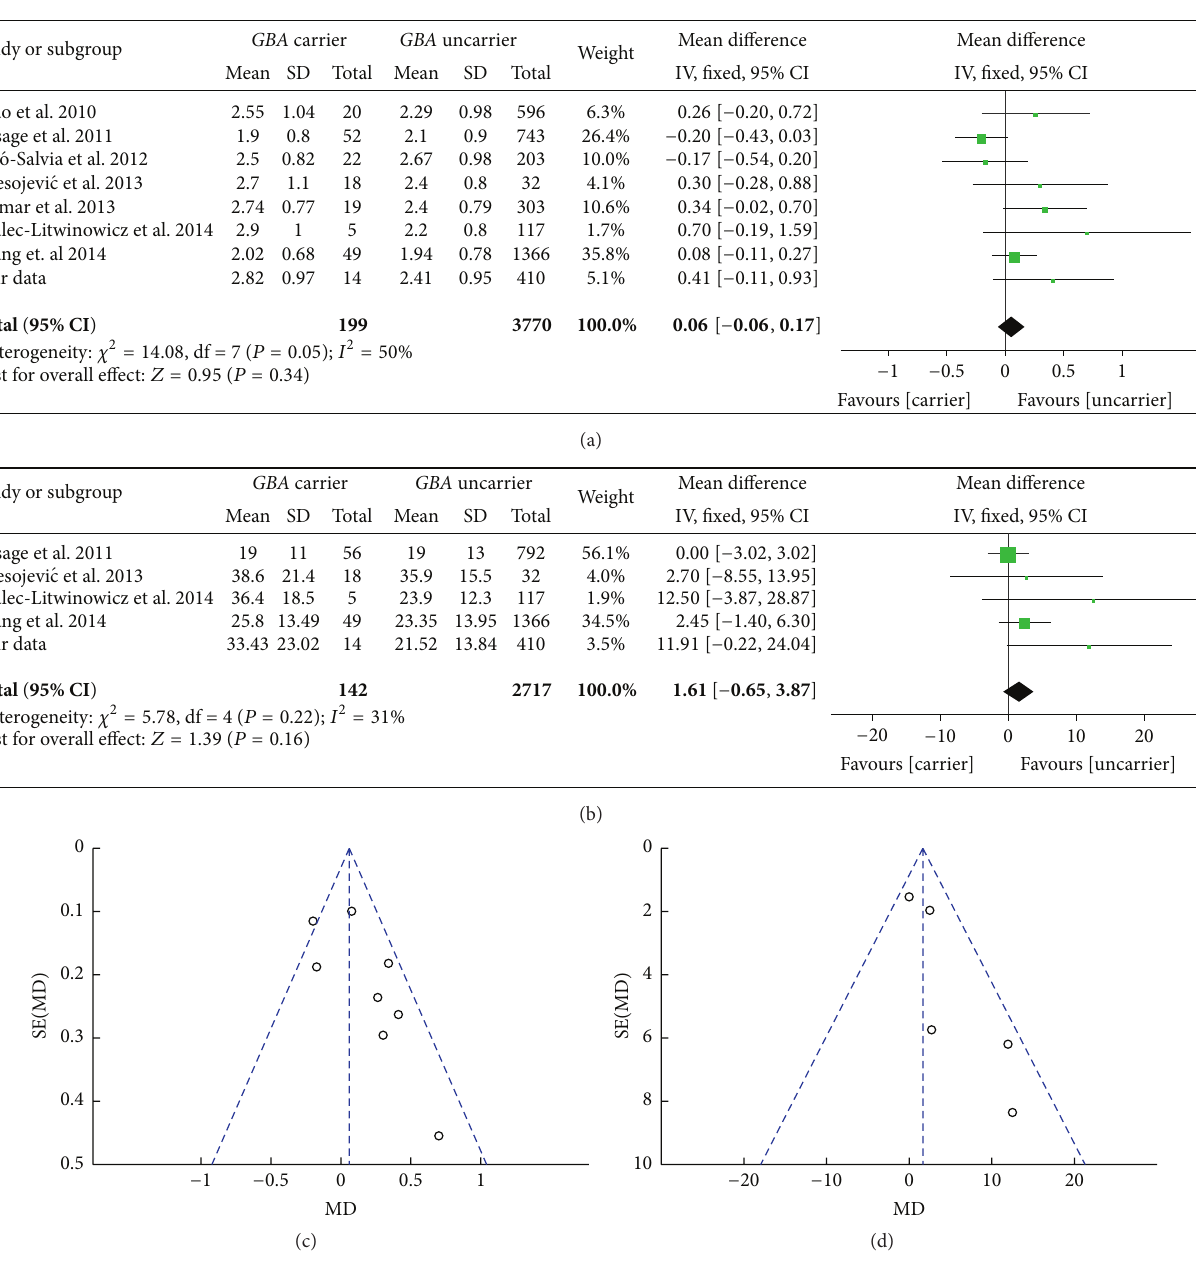
Figure 5: (a) Forest plot of H-Y in GBA + PD and GBA − PD. (b) Forest plot of UPDRS-III in GBA + PD and GBA − PD. (c) Funnel plot of H-Y in GBA + PD and GBA − PD. (d) Funnel plot of UPDRS-III in GBA + PD and GBA −